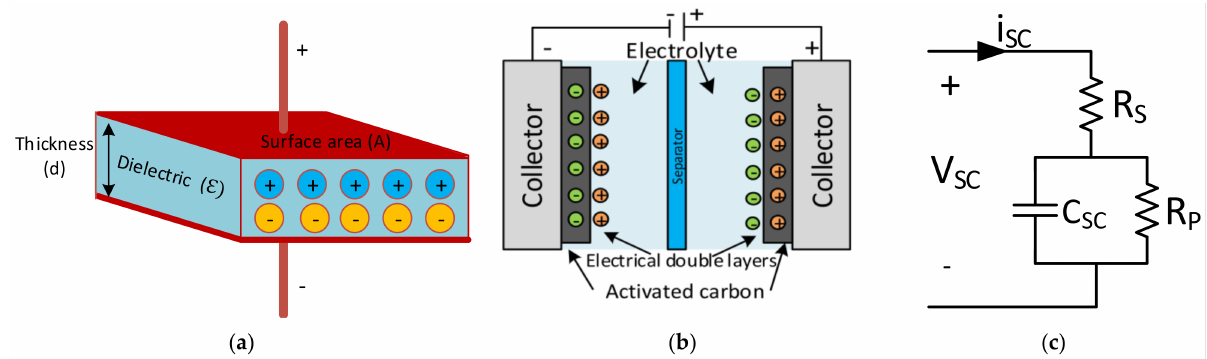
Figure 1. ( a ) Structure of electrostatic capacitor [94], ( b ) structure of SC [101], ( c ) equivalent circuit model of SC